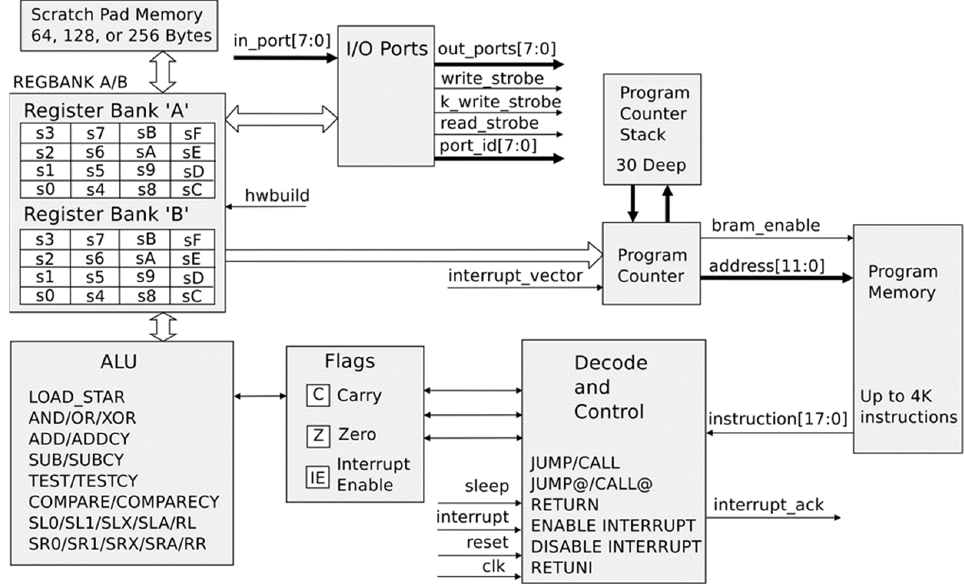
Figure 3. KCPSM6 architecture and features [16].